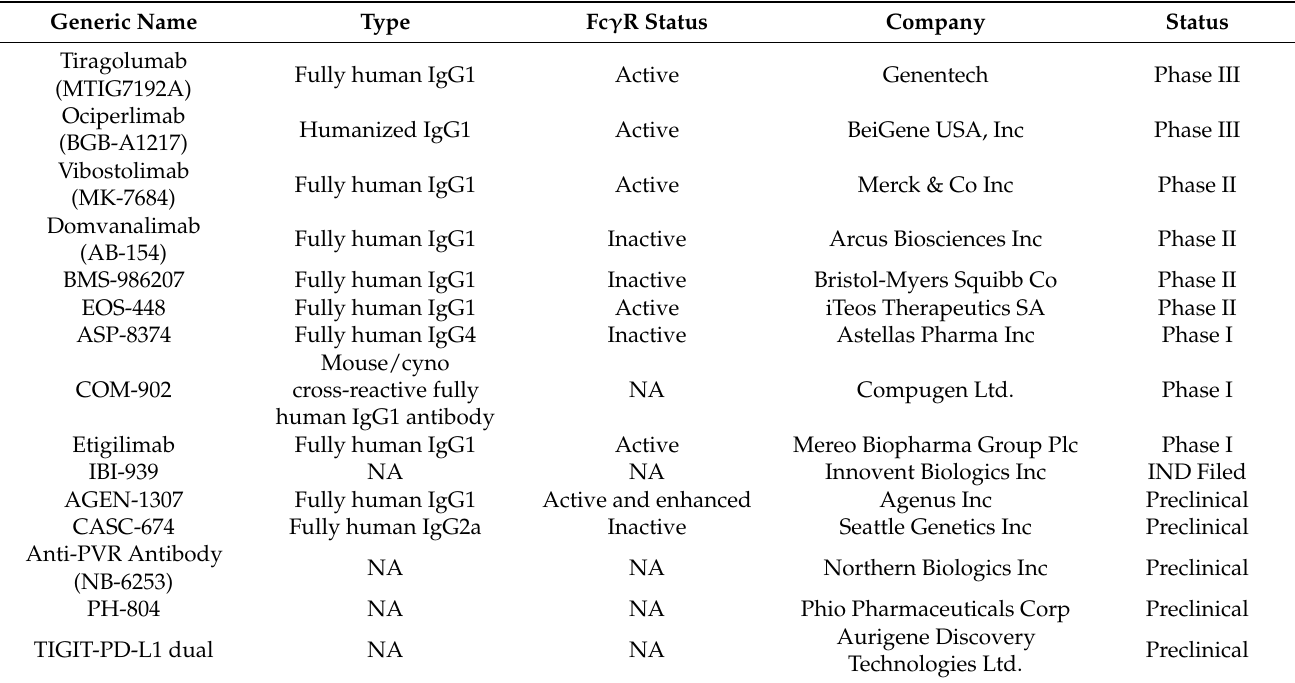
Table 3. List of anti-TIGIT molecules in clinical